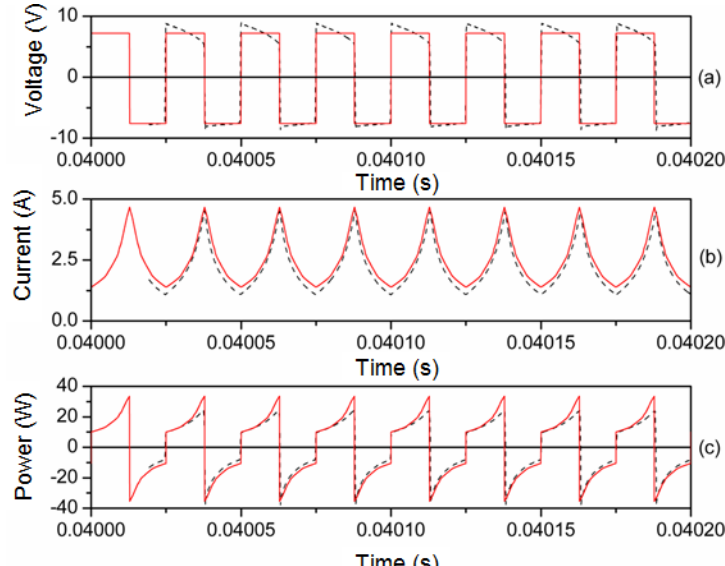
Figure 9. Experimental (-  -  -) and simulated (  ) waveforms at 40 kHz. V step  = 10 −8